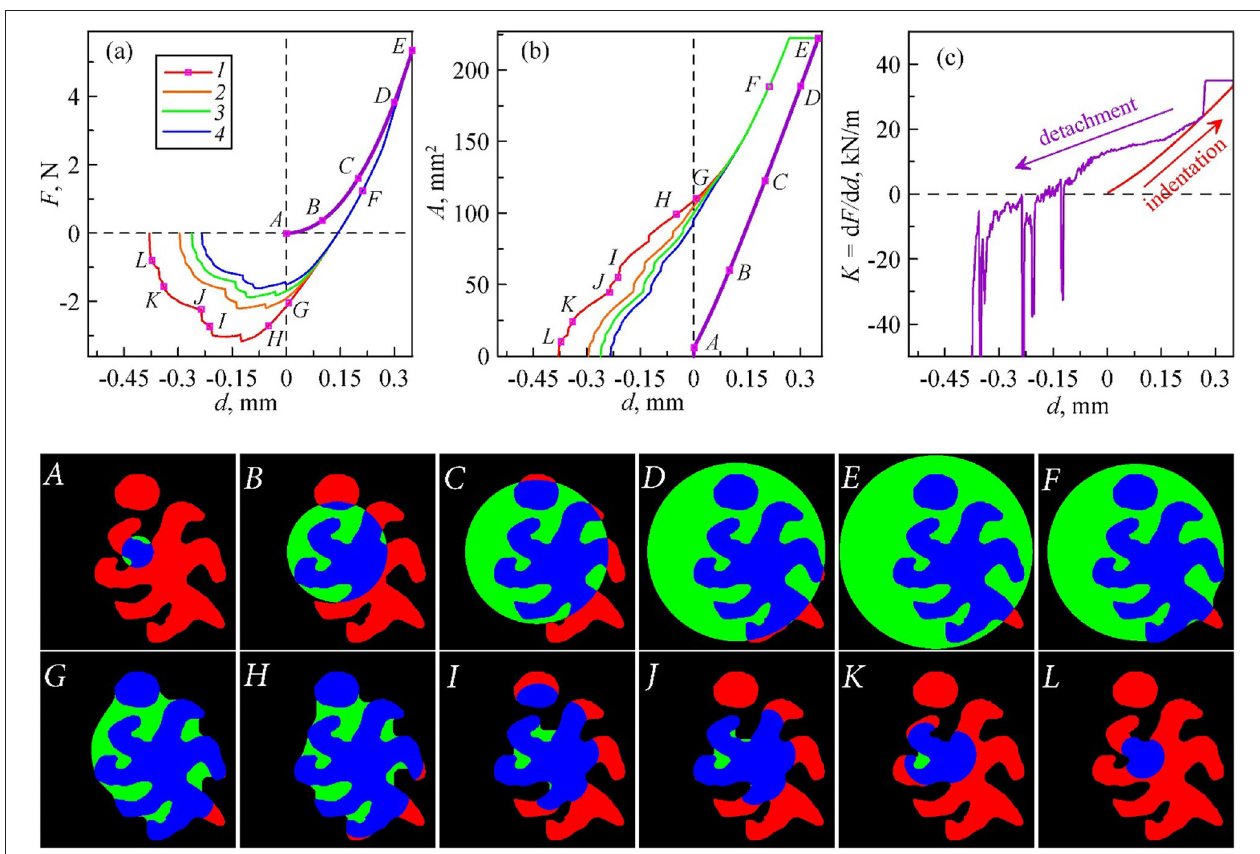
FIGURE 5 | Numerical simulation corresponding to the experiment in Figure 4 . Considered is a non-homogeneous distribution of the indenter surface energy. Dependence of: (a) normal force, (b) contact area, and (c) contact stiffness on the indentation depth. The images below show the evolution of contact zone in different colors: black—noncontact area with smaller surface energy; red—noncontact area with larger surface energy; green—contact area with smaller surface energy; blue—contact area with larger surface